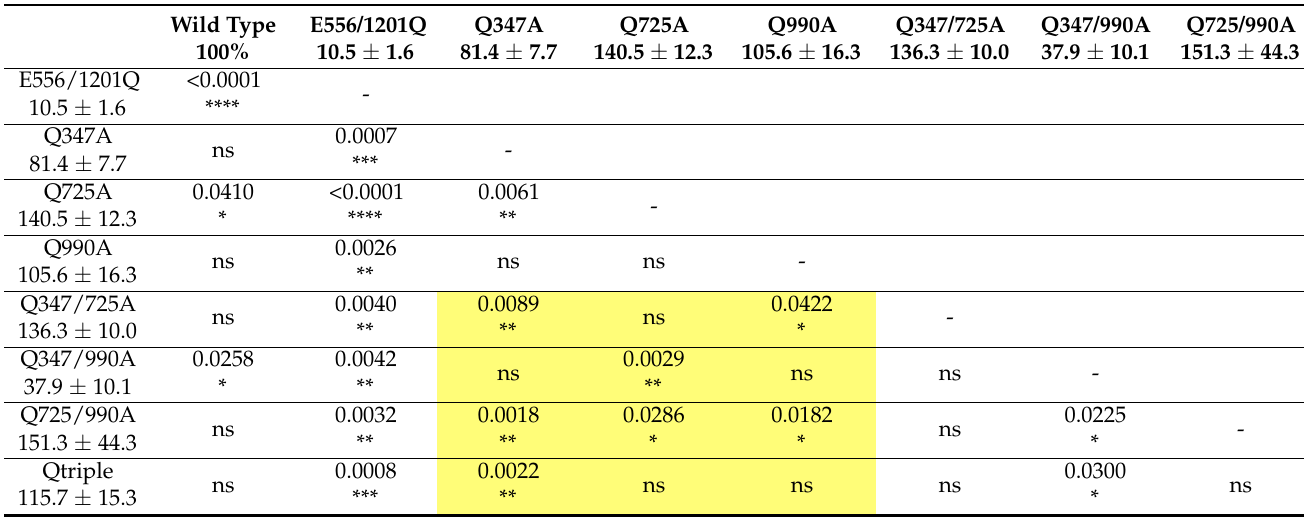
The raw data has been used for statistical comparisons. Ratio or paired Student’s t -test was used for all comparisons to wild-type ABCB1 and the Walker B mutants E556/1201Q as above. Where this was not possible, unpaired Student’s t -test was applied to the raw data (highlighted in yellow). p values: * < 0.05, ** < 0.01, *** <0.001, **** <0.0001, ns = not